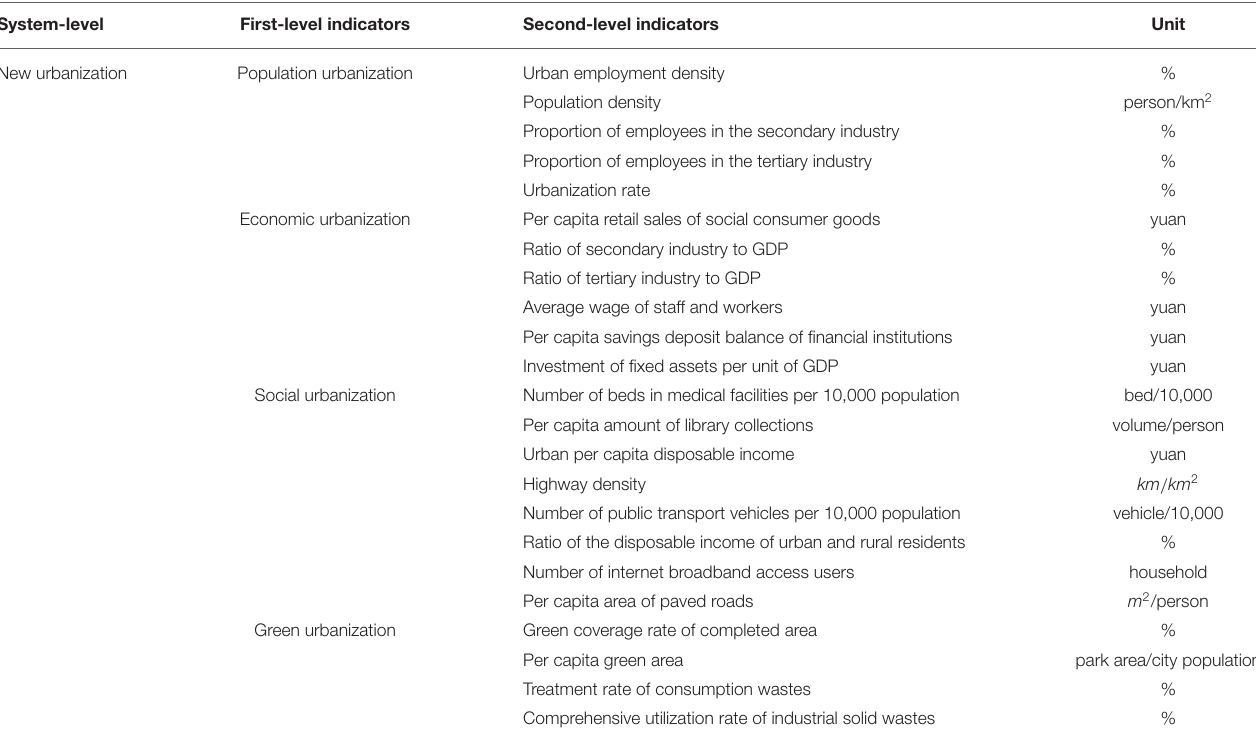
TABLE 1 | The index system of new